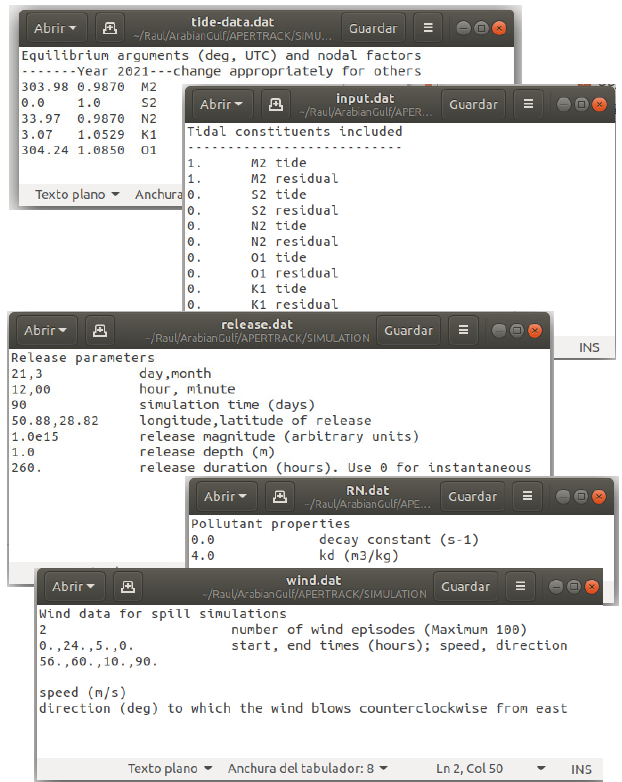
Figure 3. Files which should be edited for a given